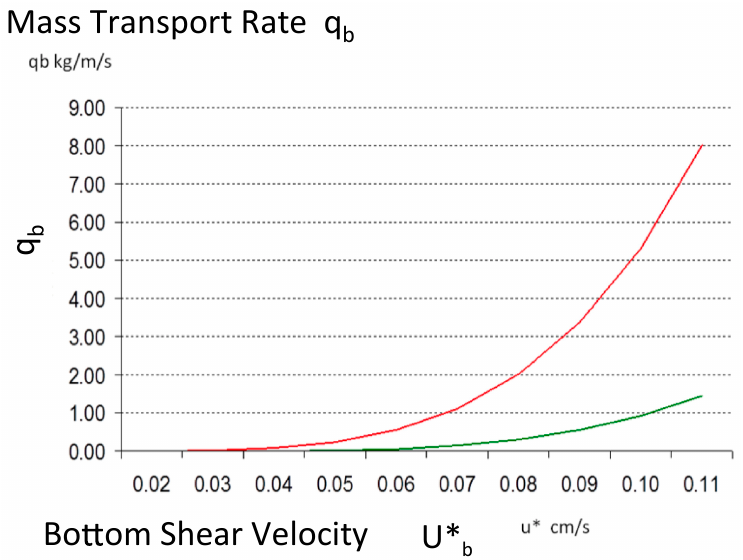
Figure 10. Graph showing mass transport rate of bottom sediment for the San Juan Channel sand wave field based on methods of Van Rijin [34] for grain sizes of 0.5 mm (red line) and 2.0 mm (green line). Assuming a conservative value of u* b = 0.05 m/s for tidal currents, based on converting of sand wave migration can be made